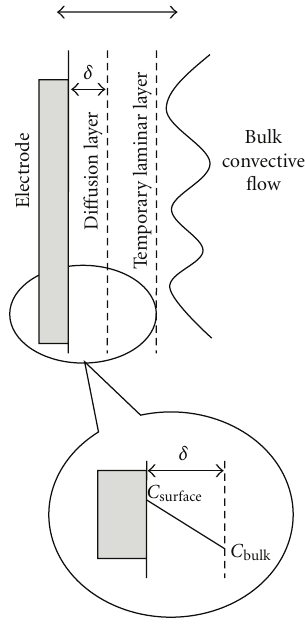
Figure 7: Schematic representation of the di ff usion and boundary layers at the electrode-solution interface as applied in the di ff usion layer model ([80], reproduced with